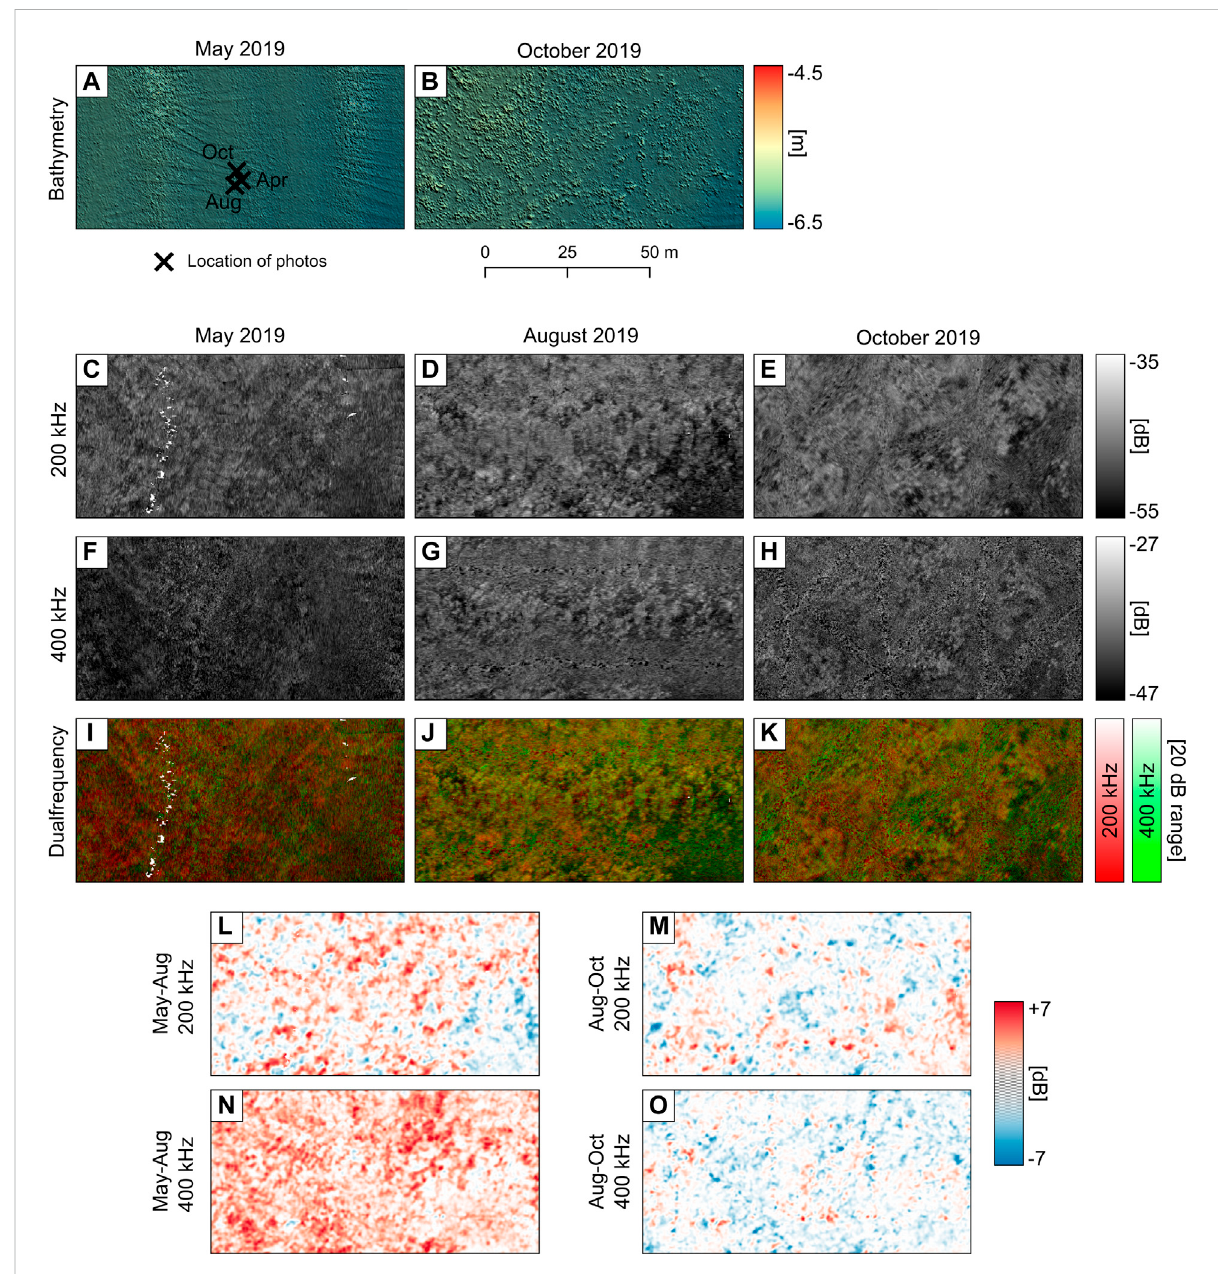
FIGURE 8 Detailed view of acoustic maps of the seagrass facies (for location see Figure 2B). (A, B) Bathymetry in May (200 and 400 kHz combined) and October (400 kHz). The resolution is 0.25 m and a hillshade is added with sun azimuth of 35 ° and sun elevation of 20 ° . In May, the sea fl oor appears smooth (in addition to artifacts), while in October many elevated seagrass patches are visible. (C – E) Backscatter mosaic at 200 kHz frequency for May, August, and October 2019. (F – H) Backscatter mosaic at 400 kHz frequency for May, August, and October 2019. (I – K) Dual-frequency backscatter mosaic for May, August, and October 2019. The 200 kHz frequency is assigned to the red color channel and 400 kHz assigned to the greencolorchannel. (L,M) Differenceplotsofthe200 kHzbackscattermosaicswitha5celllowpass fi ltershowthechangesbetweenMaytoAugust (L) andAugusttoOctober(m). (N,O) Differenceplotsofthe400 kHzbackscattermosaicswitha5celllowpass fi ltershowthechangesbetweenMay to August (N) and August to October (O)